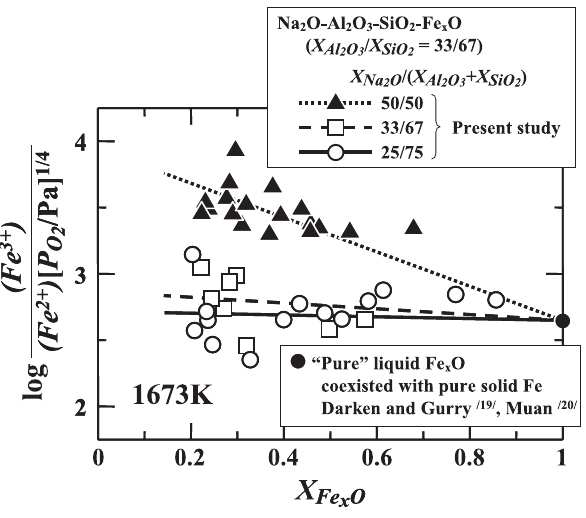
reaction (18). Figure 6 shows the relation between log{ (Fe 3 + ) / (Fe 2 + ) P slags. The value for pure non­stoichiometric liquid Fe coexisted with pure solid iron is based upon the works by Darken and Gurry /19/, and Muan /20/. As shown in this figure, the values for log{ (Fe 3 + ) / (Fe 2 + ) P an increase in X increase in slag basicity. This result indicated that the oxidation­reduction equilibrium for the Fe 3 + /Fe 2 + couple could be given by reaction (12) for the Na Fe O slags investigated in this study; ferric ion could be x expressed by (FeO melts would behave as an amphoteric oxide.